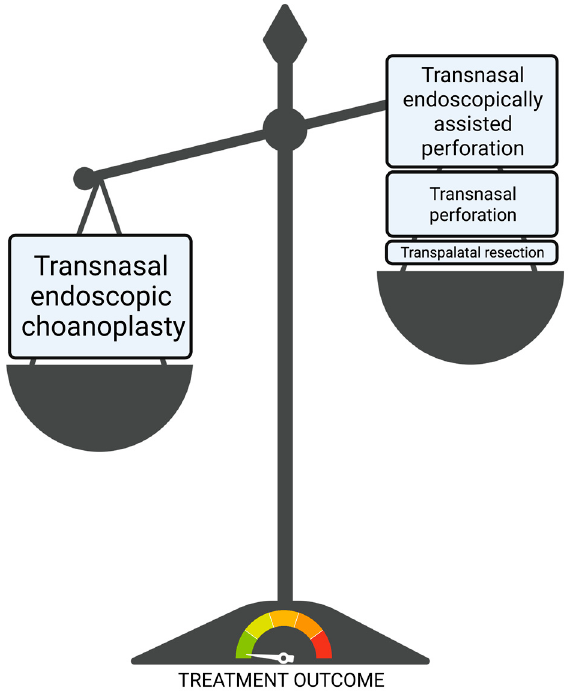
Figure 4. Types of surgical treatment methods of choanal atresia. Transnasal endoscopic choanoplasty is the gold standard with the best treatment outcome and lowest restenosis rate. Other surgical techniques present an alternative, e.g., transnasal endoscopically controlled perforation in cases where the manipulation with instruments is impossible due to the size of the nasal cavities, for example, in preterm infants. Transnasal perforation and transpalatinal resection represent the hierarchical bottom of surgical techniques and should not be performed.